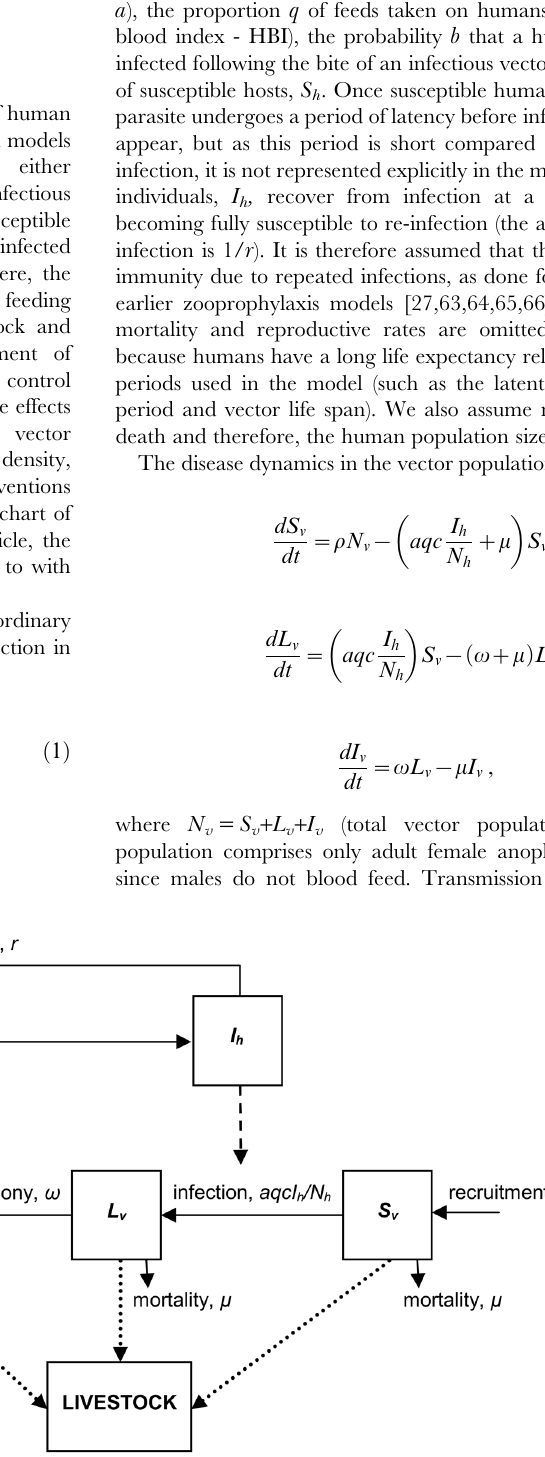
Figure 1. Schematic representation of the malaria model. Horizontal solid lines denote transitions between epidemiological states, and dashed lines represent transmission of infection between human hosts and mosquito vectors. Dotted lines denote vectors feeding on livestock. The vector population consists of adult female anopheline mosquitoes.